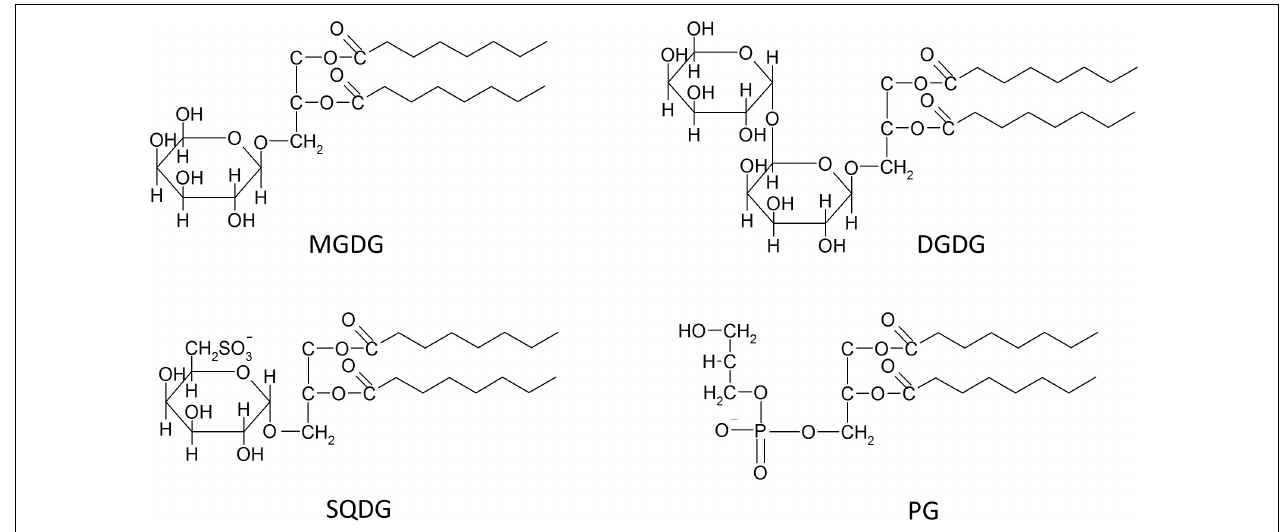
FIGURE 1 | Schematic structures of the four main thylakoid membrane lipids, i.e., the three glycosylglycerol lipids (GGLs) monogalactosyldiacylglycerol (MGDG), digalactosyldiacylglycerol (DGDG) and sulfoquinovosyldiacylglycerol (SQDG), and the one glycerophospholipid (GP) phosphatidylglycerol (PG).